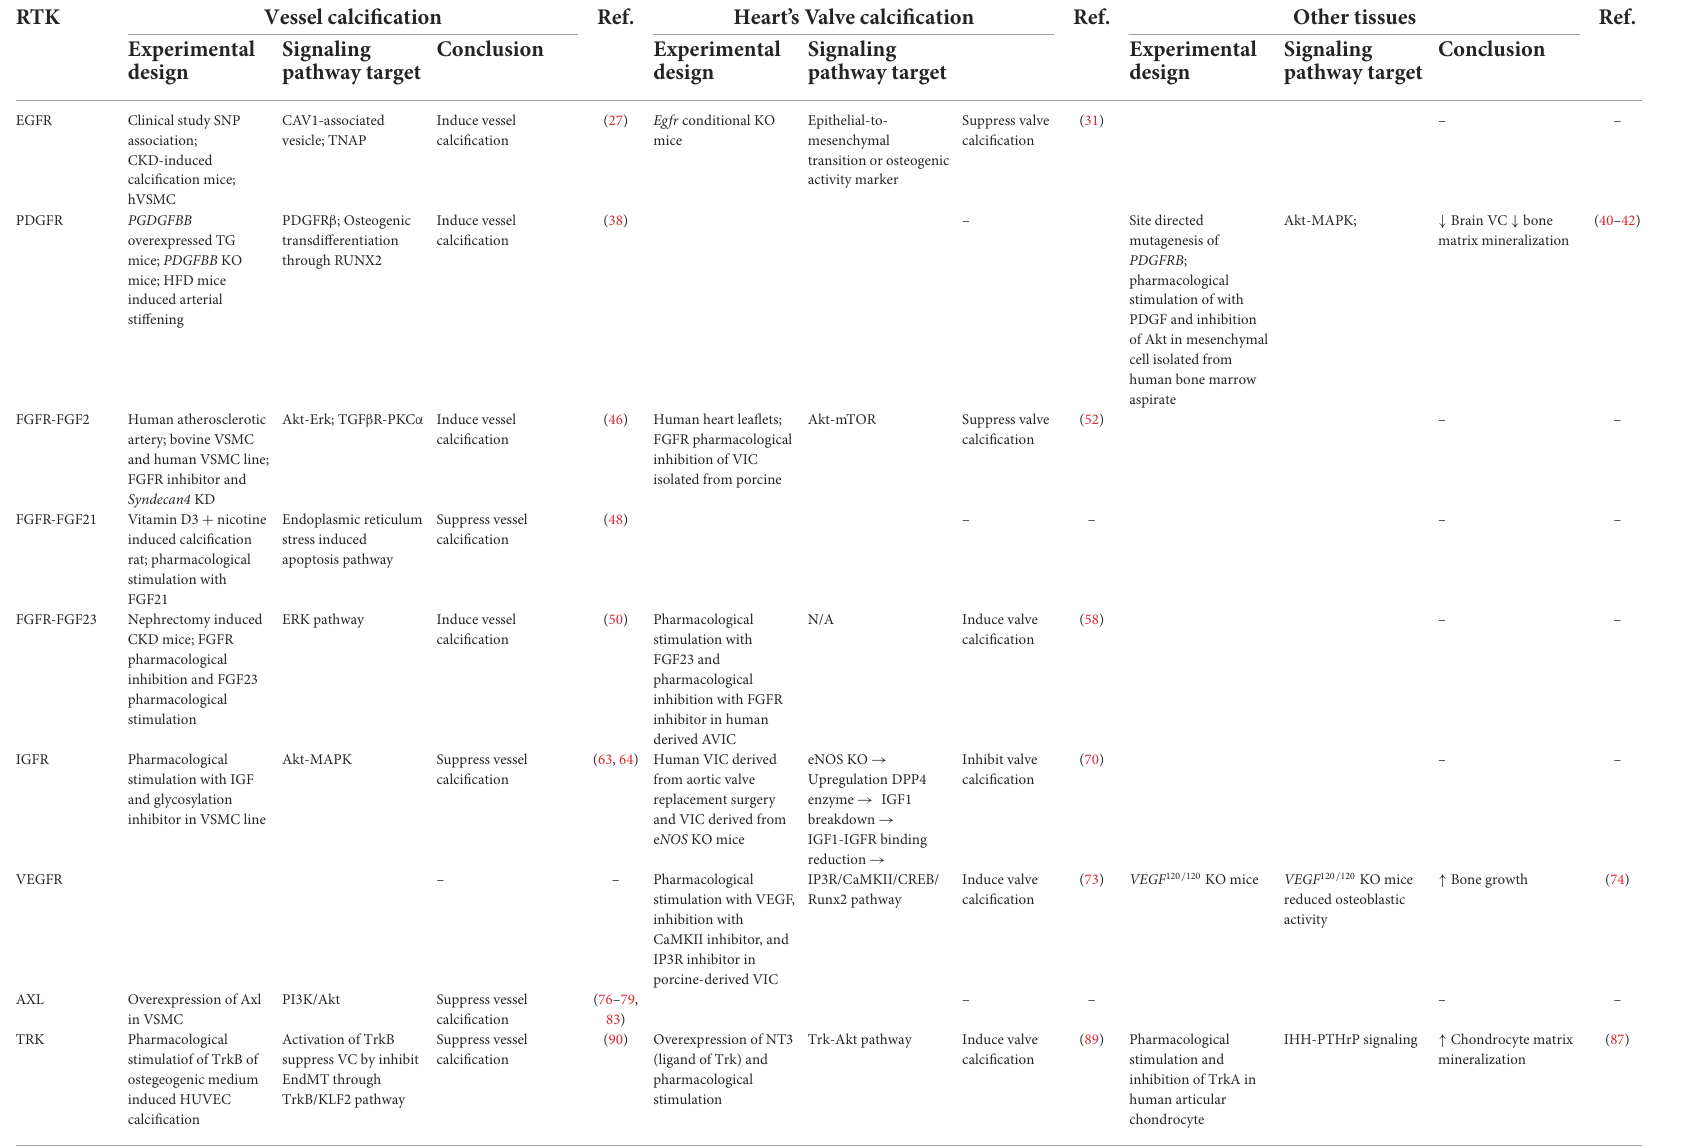
TABLE 2 Summary of RTKs involvement in cardiovascular calcification.